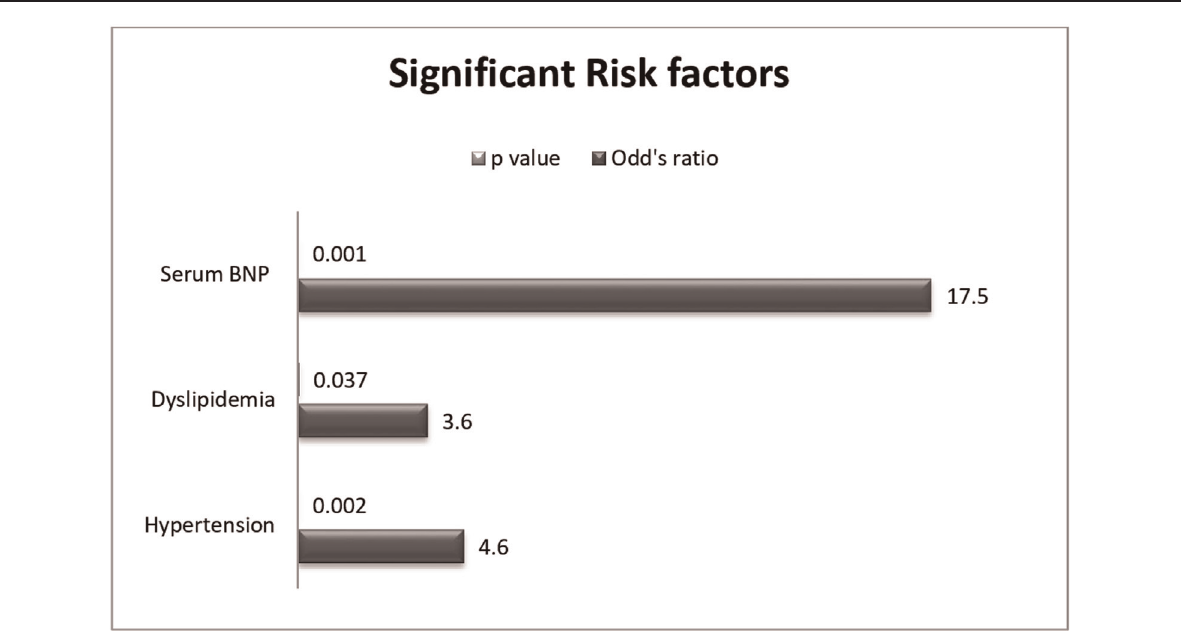
Significant risk factors for CVD in patients with COPD using multiple linear regression analysis. COPD, chronic obstructive pulmonary disease; CVD, cardiovascular